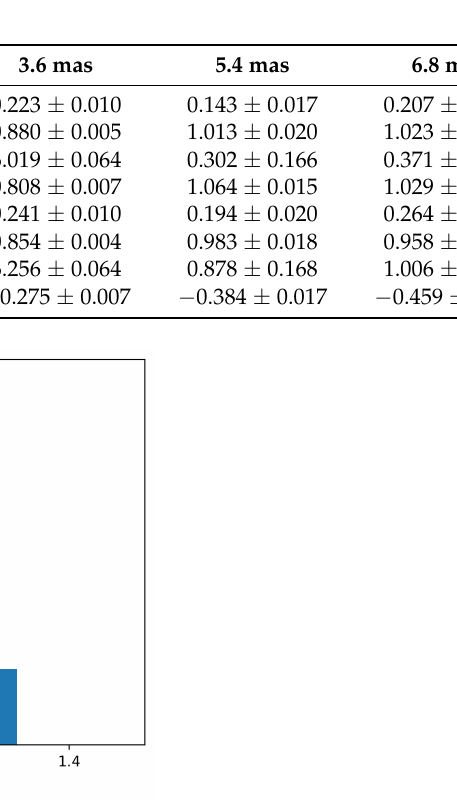
Figure 4. Distribution of period of the transverse oscillations obtained from sinusoidal fit at all distances less than 12 mas. The average period is 0.94 yr, and the standard deviation is 0.12